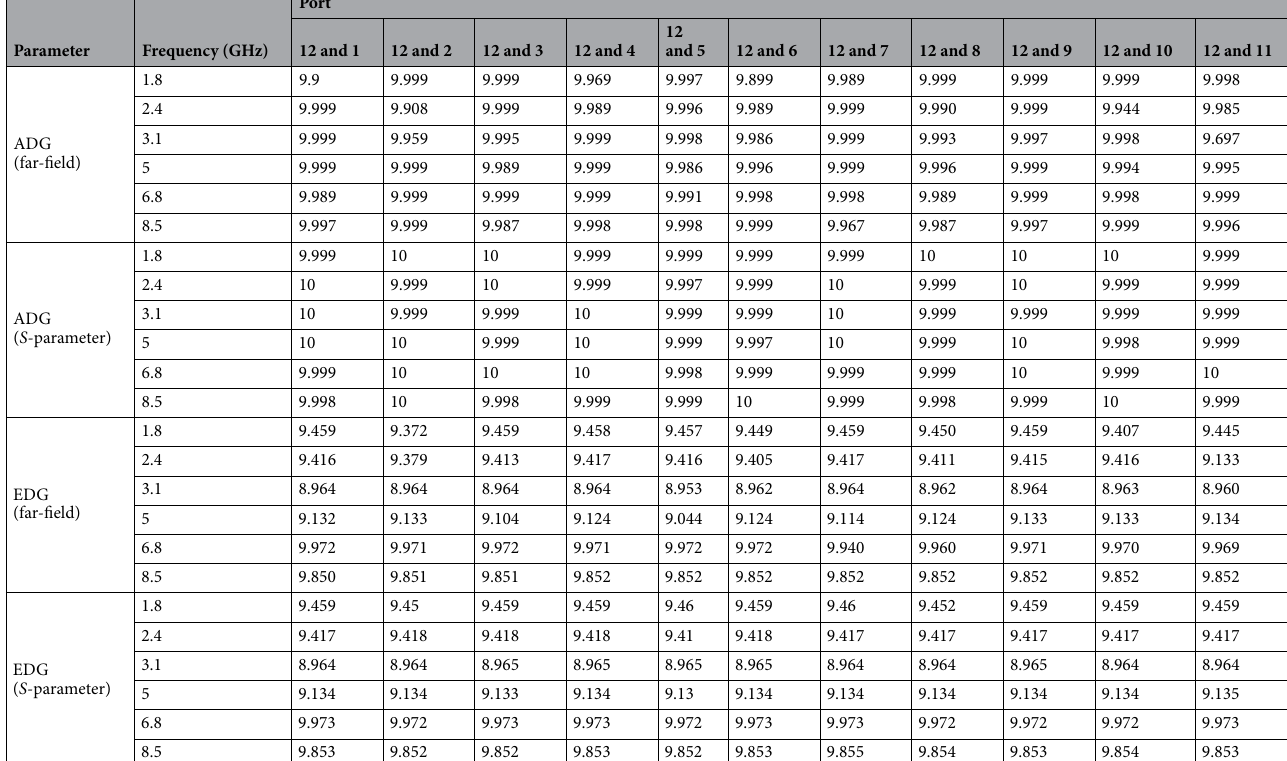
Table 4. ADG and EDG of the proposed antenna in relation to